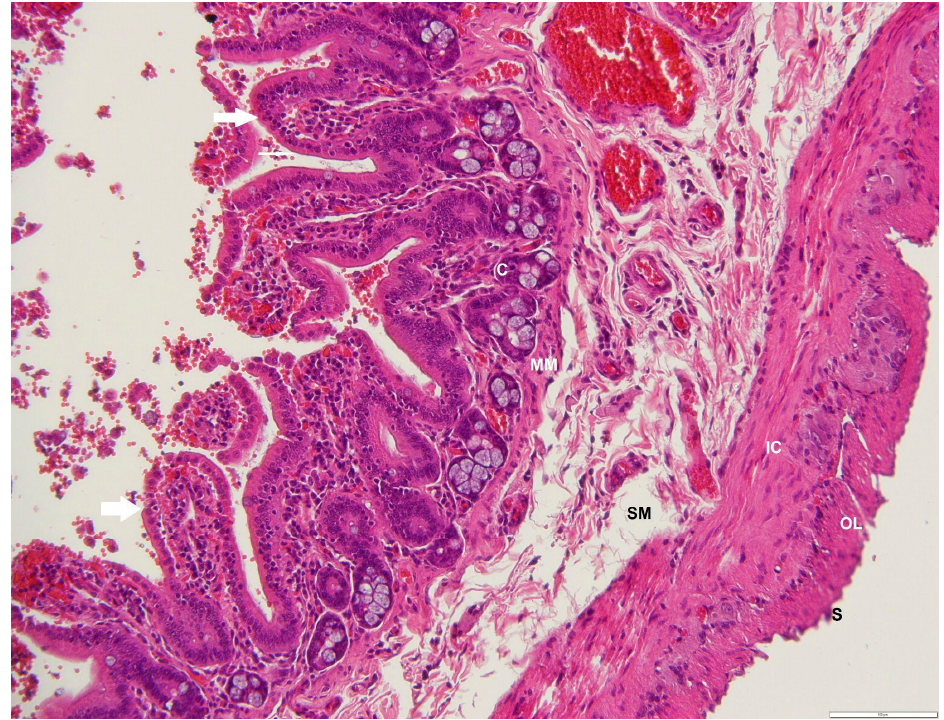
Figure 10. Photomicrograph of a transverse section through the jejunum of an adult male D. leporina , showing villi (arrows). H&Ex200. MM—muscularis mucosa; C—intestinal crypts; SM—submucosa; IC—inner circular layer; OL—outer longitudinal layer; S—serosa.